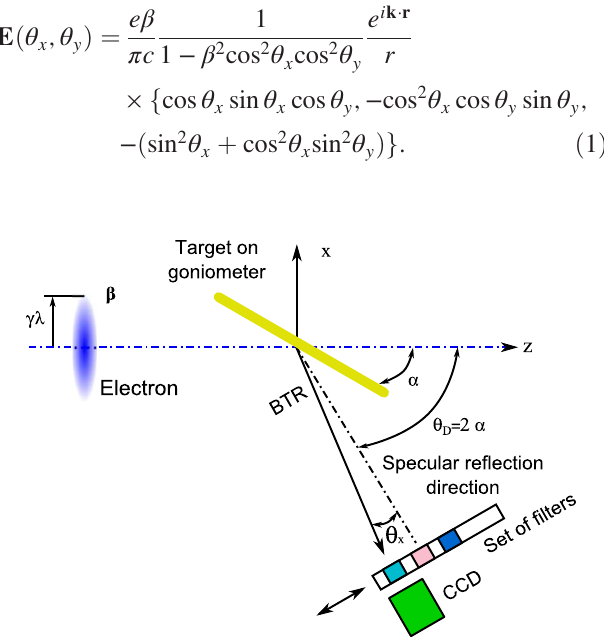
FIG. 1. Sketch of the setup for the experiment dedicated to the investigation of EUV